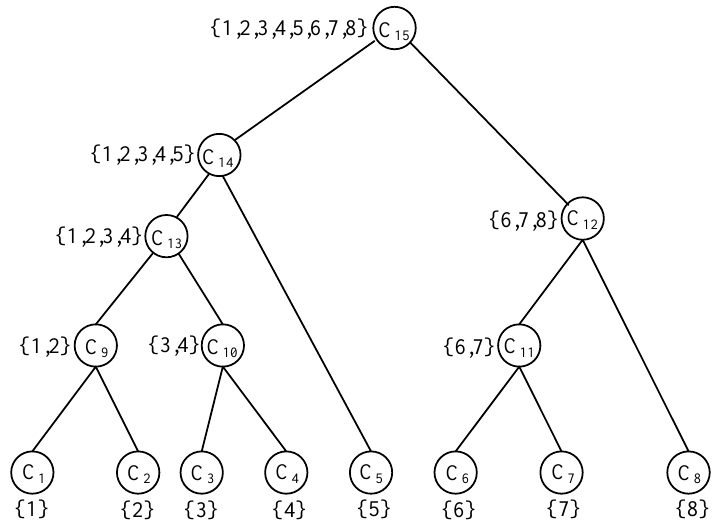
Fig 4: An example hierarchical clustering on eight videos. Each cluster is expressed by the set of videos in that cluster.